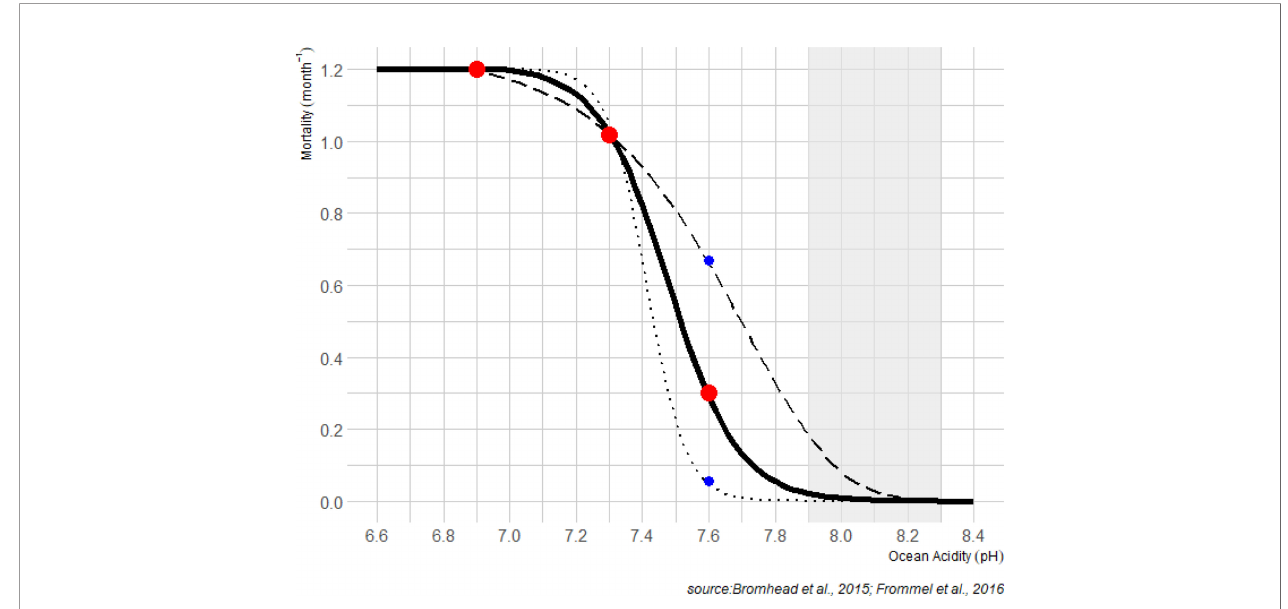
FIGURE 1 | Change in additional monthly mortality rates of yellow fi n larvae deduced from experimental results (Bromhead et al., 2015; Frommel et al., 2016) corresponding to 70%, 64% and 27% (red points) decrease in larvae survival during fi rst 7 days of life at pH value of 6.9, 7.3, 7.6 respectively. The solid line shows the analytical function implemented in SEAPODYM to account the impact of acidi fi cation with these three mean values (scenario SOA1). Two other curves (dashed, SOA2 and dotted, SOA3) are high and low sensitivity scenarios to account uncertainty at higher levels of pH. The shaded area corresponds to the historical pH values estimated in the epipelagic layer of the ensemble models (see Figure 2